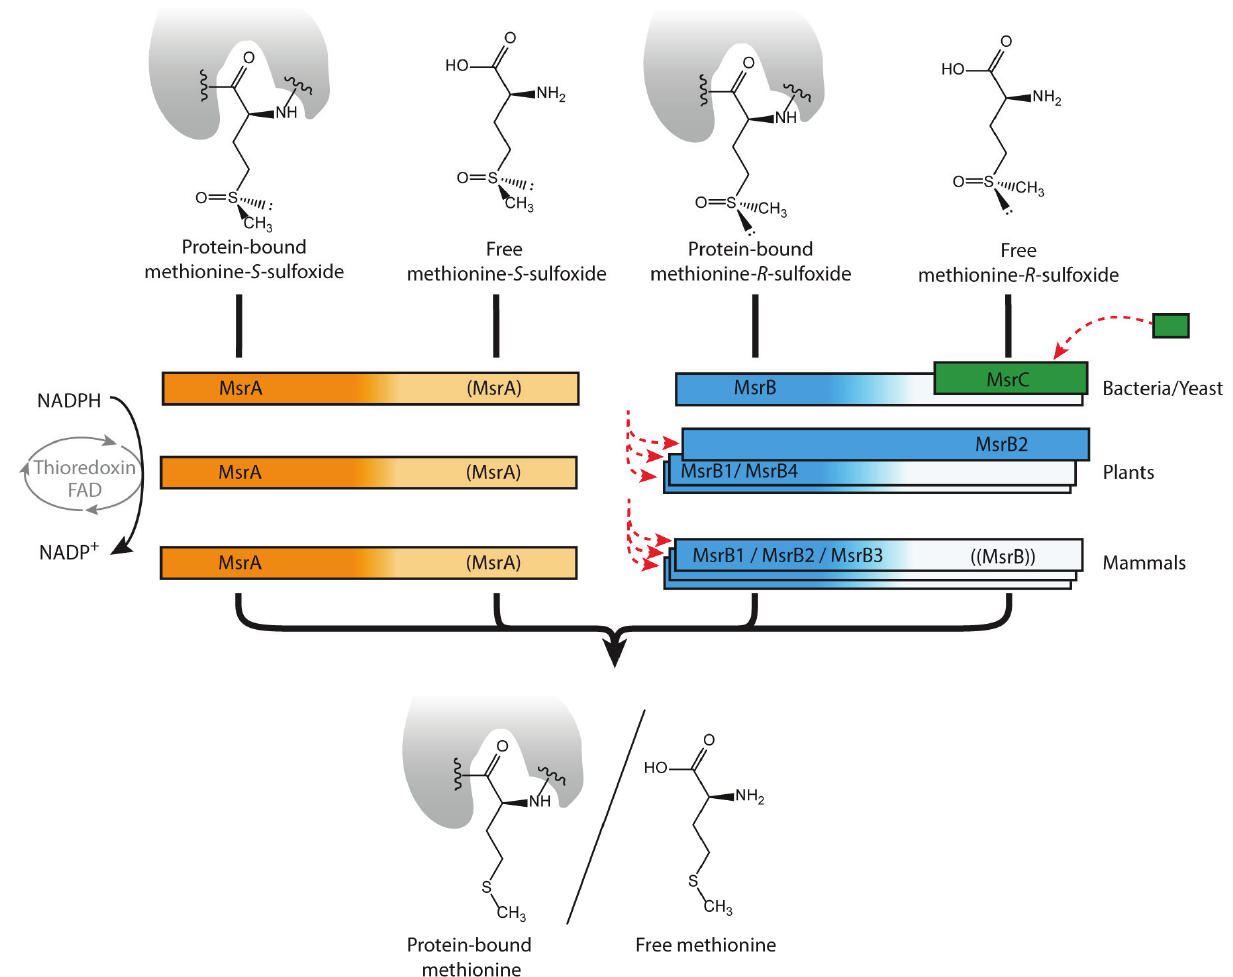
Figure 2. Oxidative damage on methionine and its repair enzymes. Methionine is oxidized to methionine- S -sulfoxide and methionine- R -sulfoxide derivatives. Three families of methionine sulfoxide reductases (Msr, different colors), revert the process depending on thioredoxin, each being stereo-specific against the R - or the S -enantiomeric form. While MsrA and MsrB are highly conserved with preference for protein integrated methionine sulfoxides, MsrC (f R Msr) is limited to unicellular organisms and reduces free methionine- R -sulfoxide. MsrB has evolved by duplication and divergence (red dashed arrows), accounting for coverage of diverse subcellular localizations, and enabling in plants the appearance of a subtype active against the free methionine- R -sulfoxide. Color intensities illustrate different strength in catalytic